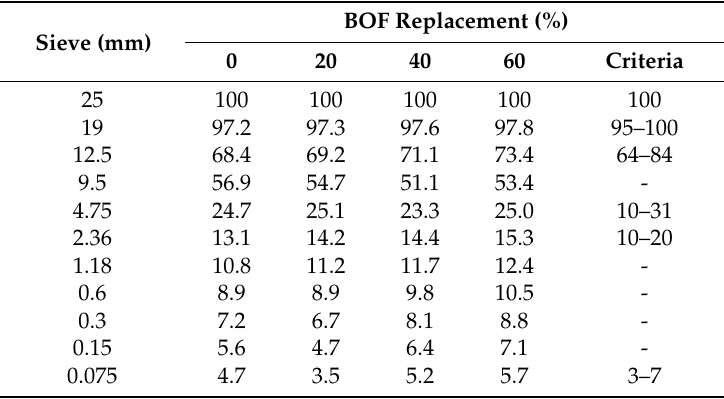
Table 5. Sieve distribution (porous asphalt (PA)-graded